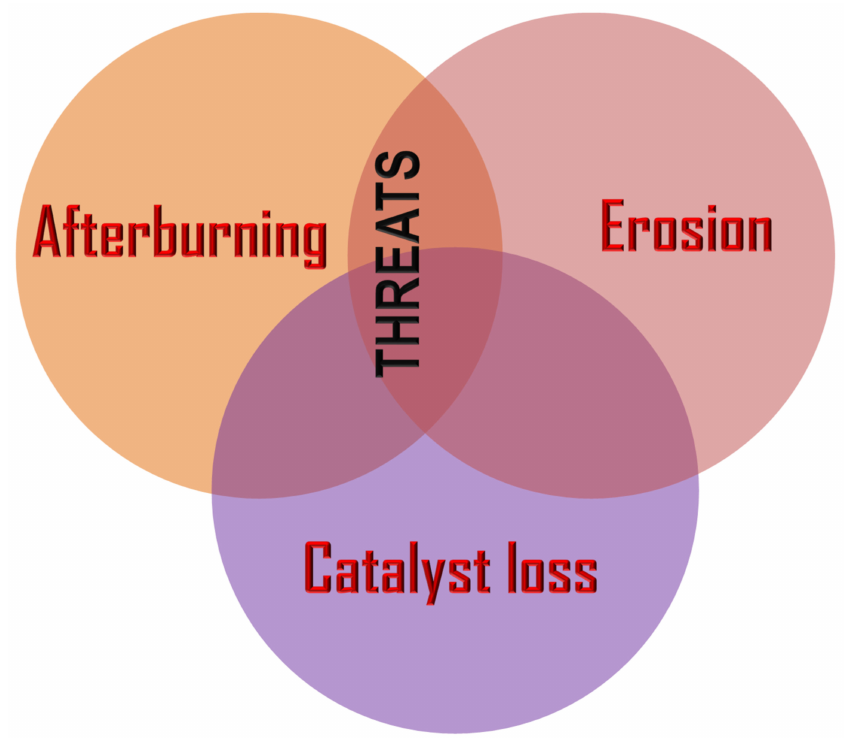
Figure 21. Major reliability issues in FCC